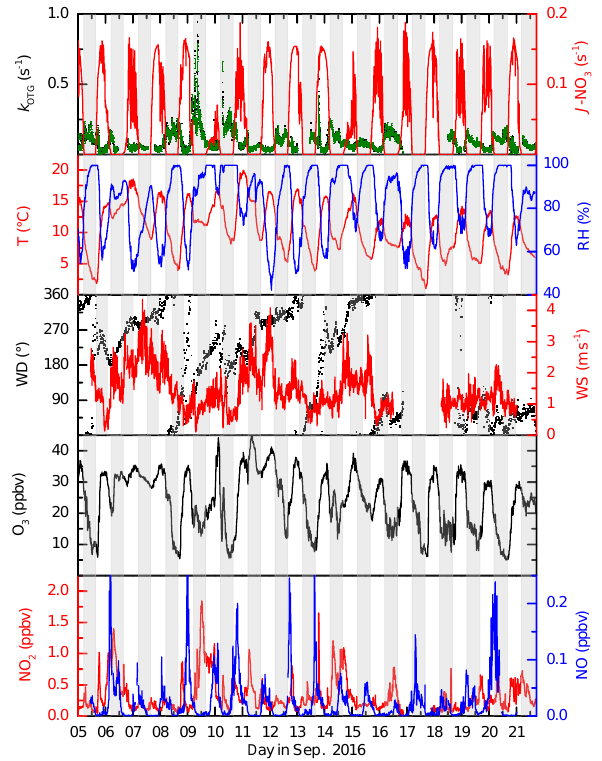
Figure 2. Overview of measurements during IBAIRN. The grey shaded regions represent nighttime. The uncertainty in k OTG is given by the green shaded region. Measurements were obtained from the common inlet at a height of 8.5m apart from the NO 3 photolysis rate (taken from a height of 35m on an adjacent tower), wind direction (WD) and wind speed (WS) (both at 16.5m on the 128m tower). A time series of k OTG is given in log scale in the Supplement (Fig.